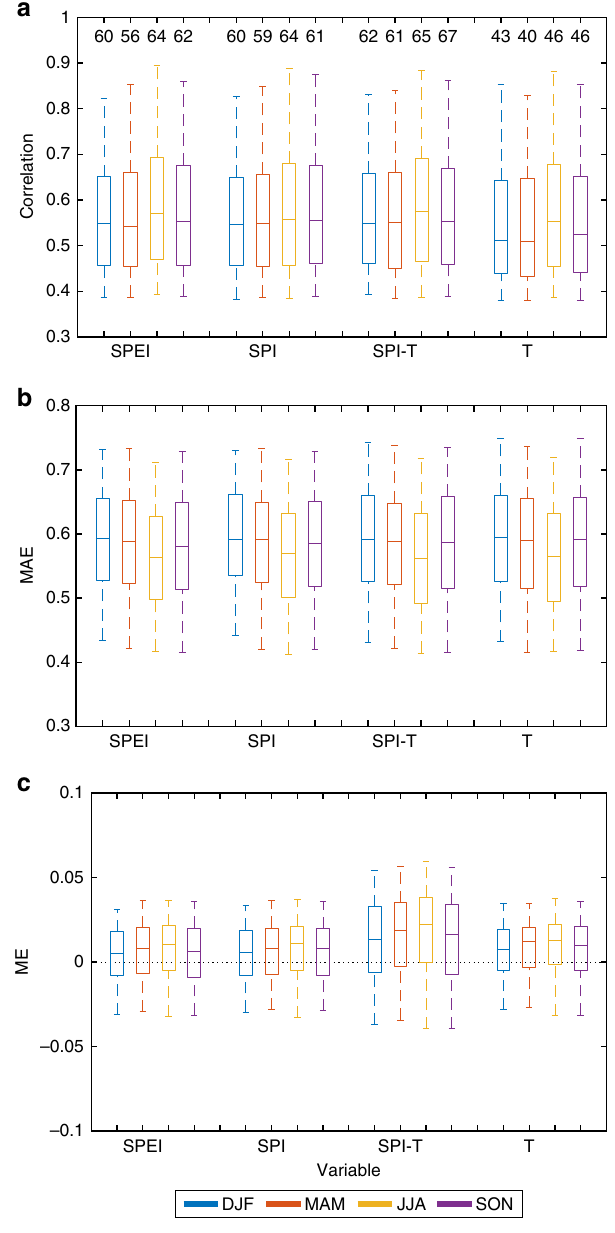
Fig. 3 Summary of burned area prediction skill obtained using different observed climate indicators and metrics. Boxplots of the spatial distribution of a correlation values (numbers above the boxes represent the percentage of the domain area with signi fi cant correlations, i.e. number of green against grey plus green points in Fig. 2), b mean absolute error values (MAE) and c mean error (ME) for the burned area predictions based on SPEI, SPI, SPI and temperature (SPI – T model) and temperature alone (T model) for the four seasons (depicted with different colours). The median is shown as a solid line, the box indicates the 25 – 75 percentile range while the whiskers show the 2.5 – 97.5 percentile